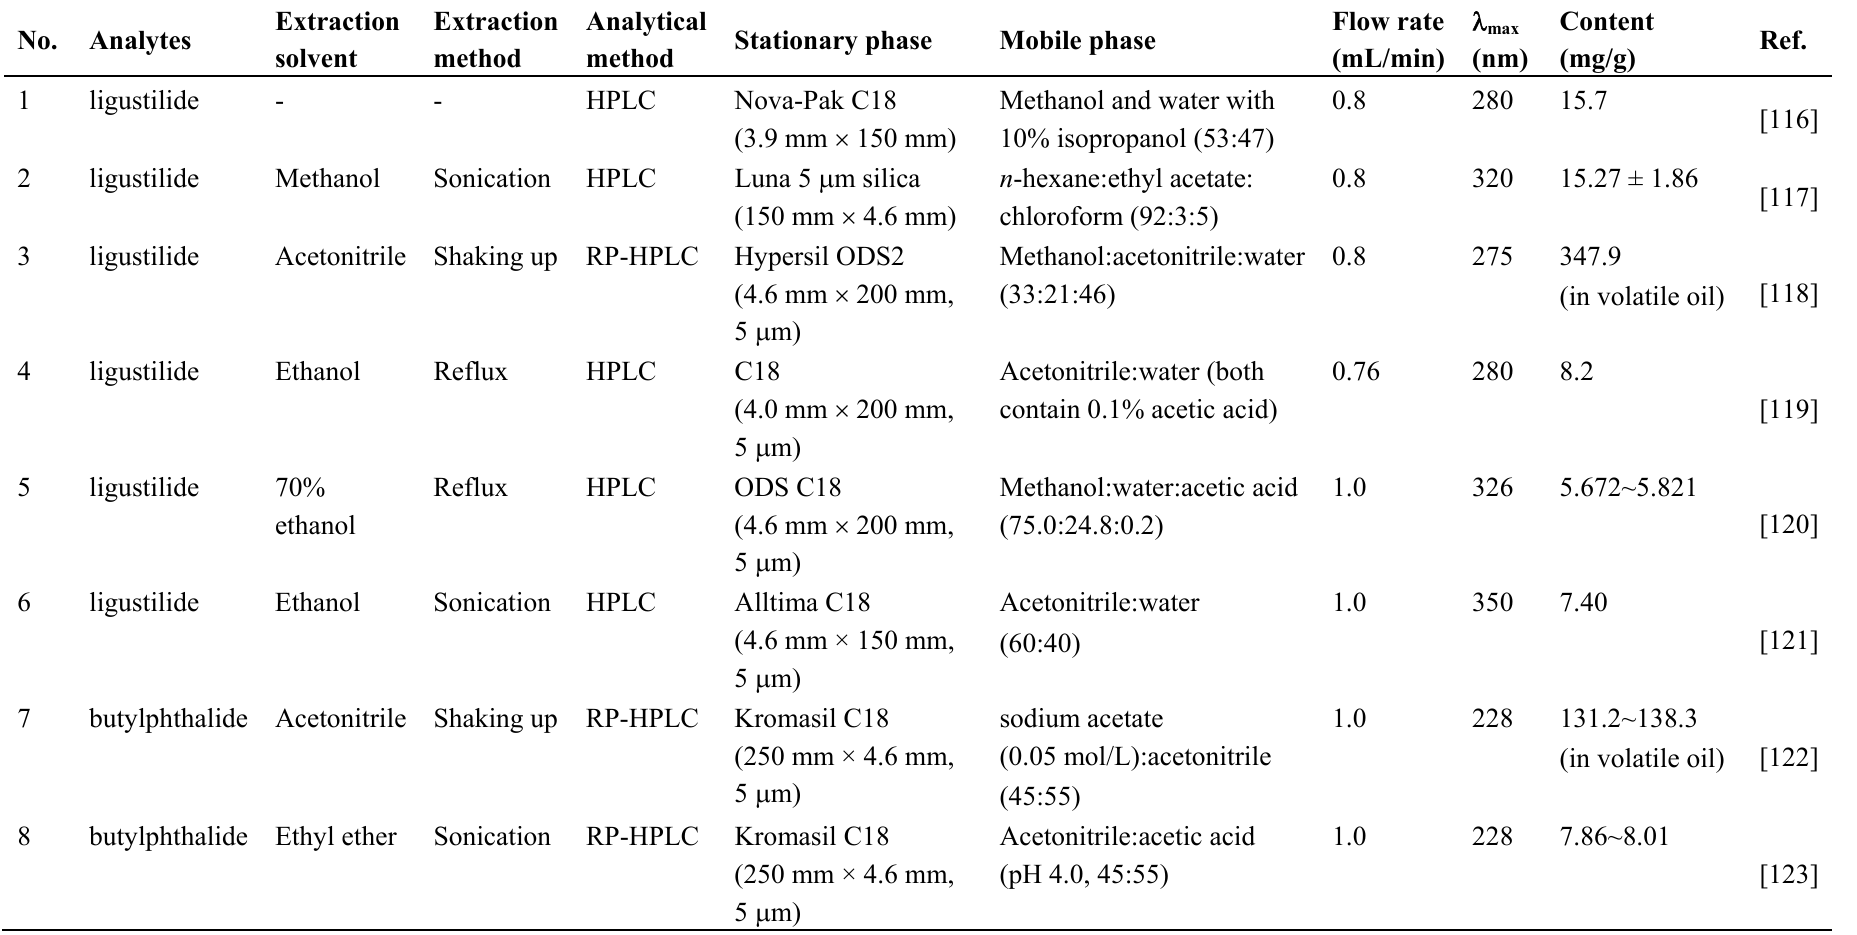
Table 3. The concentration variation of ligustilide ( 19 and/or 20 ) and butylphthalide ( 39 ) in CX analyzed by